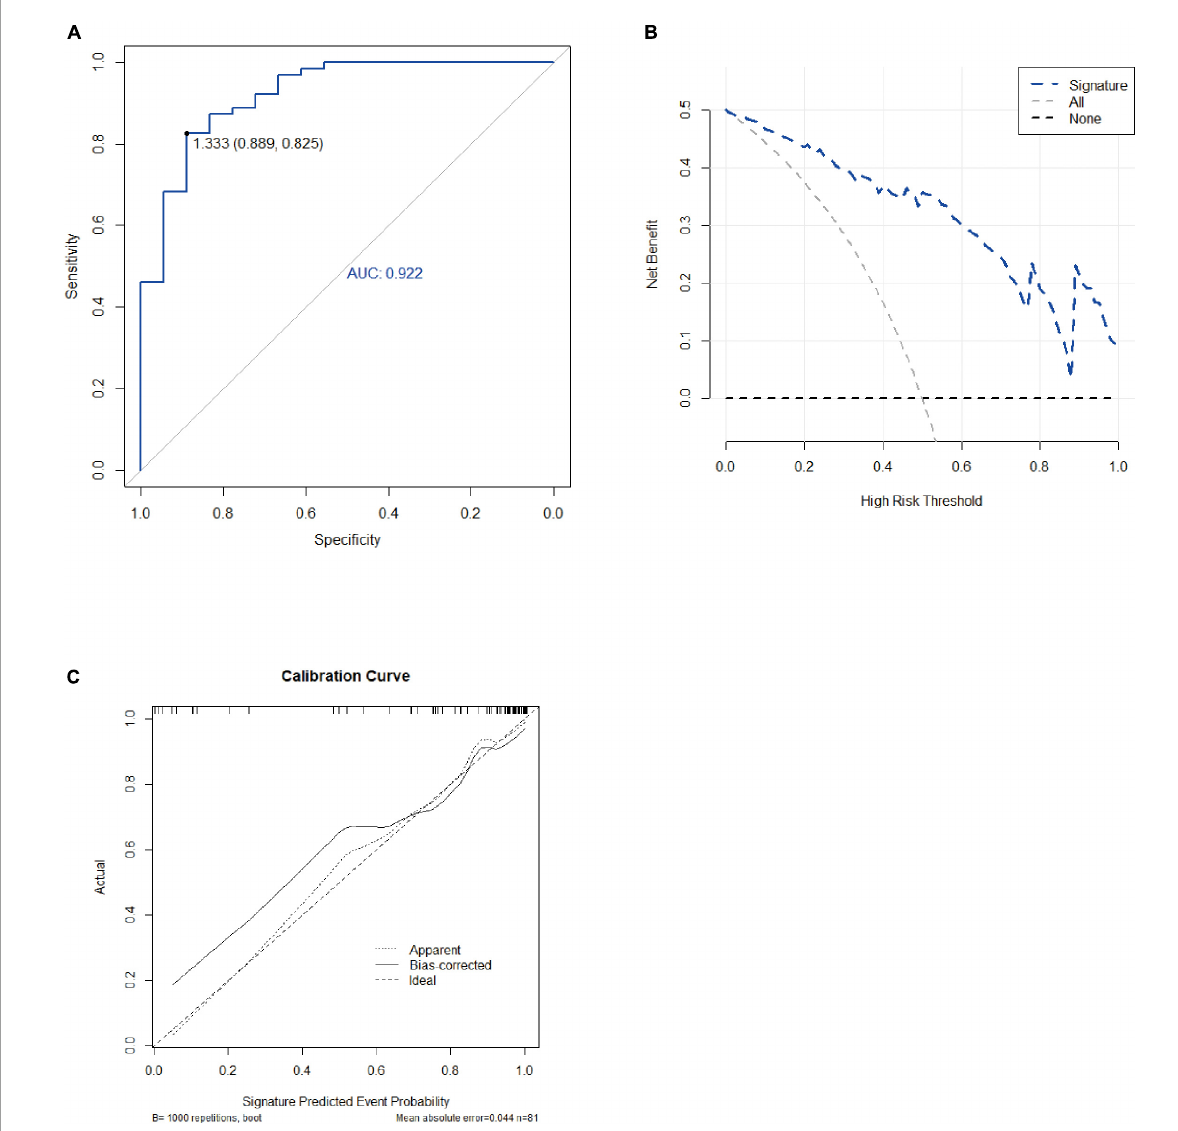
FIGURE6 Testing of the model. ROC, DCA, and calibration curve were used to detect 10 hub genes. (A) ROC curves of the ferroptosis-related gene signature that was a candidate for differential expression. (B) DCA of the candidate ferroptosis-related gene signature. (C) Calibration curve of the model. DCA, decision curve analysis; ROC, receiver operating